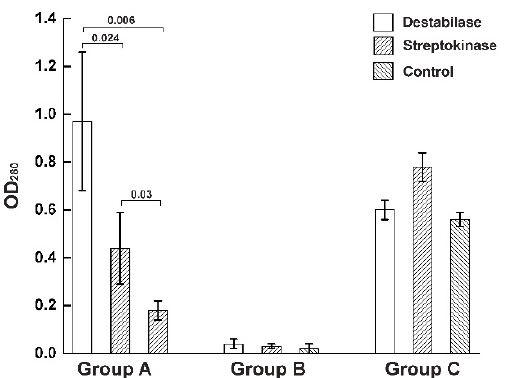
Figure 3. Clustering data analysis of the degree of destabilization of blood clots. Three groups were formed: A, a group of blood clots that dissolve better in 2% acetic acid after treatment with destabilase than after treatment with streptokinase or control buffer; B, a group of blood clots that do not dissolve in acetic acid; C, a group of blood clots that dissolve well in acetic acid, regardless of the solution with which the samples were treated. The OD 280 axis shows the absorbance of the supernatant of a dissolved in 2% acetic acid blood clots at a wavelength of 280 nm. Each group contains mean OD 280 values of samples after blood clot destabilization assay and data clustering. The data are expressed as mean ± CI95. Significant differences are indicated by asterisk brackets with the p -value. The significance level of the null statistical hypothesis was taken as 0.05.